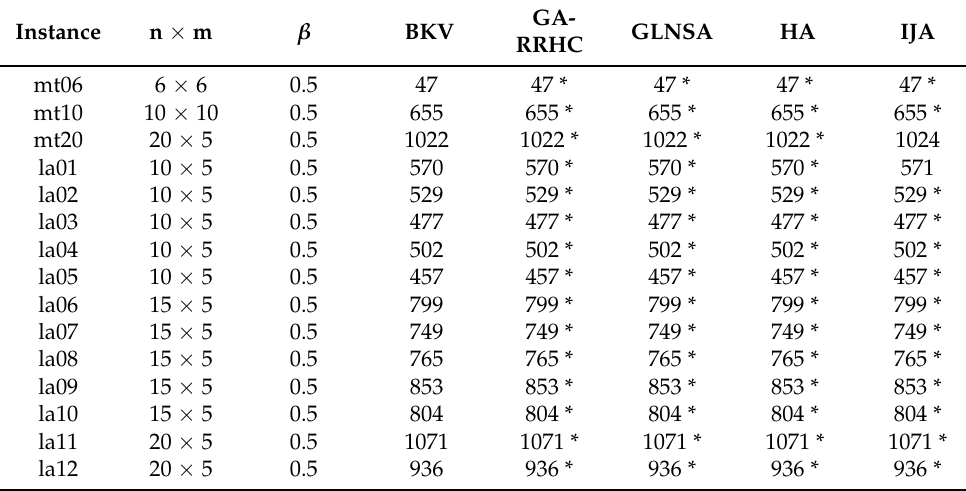
Table 9. Vdata dataset results, best makespan values are marked with